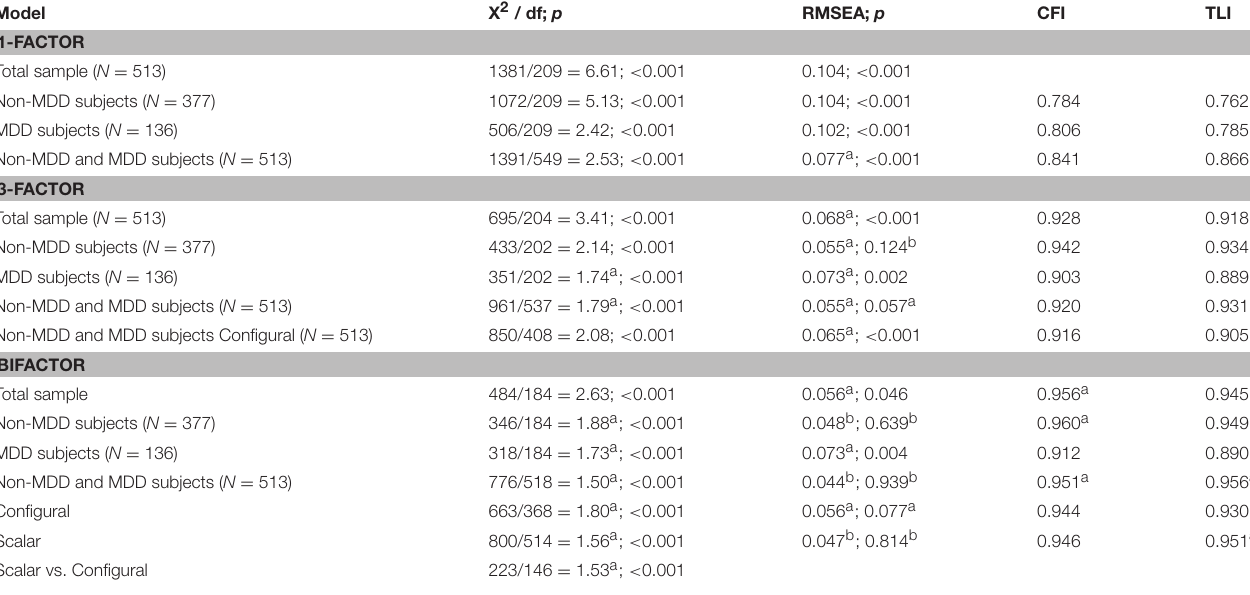
TABLE 3 | Factor Analysis of the